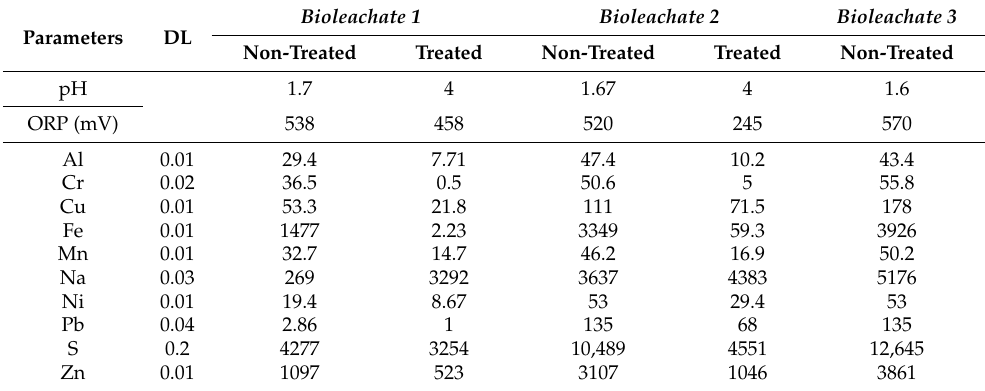
Table 2. Characteristics and chemical composition (mg/L) of the three bioleachates.